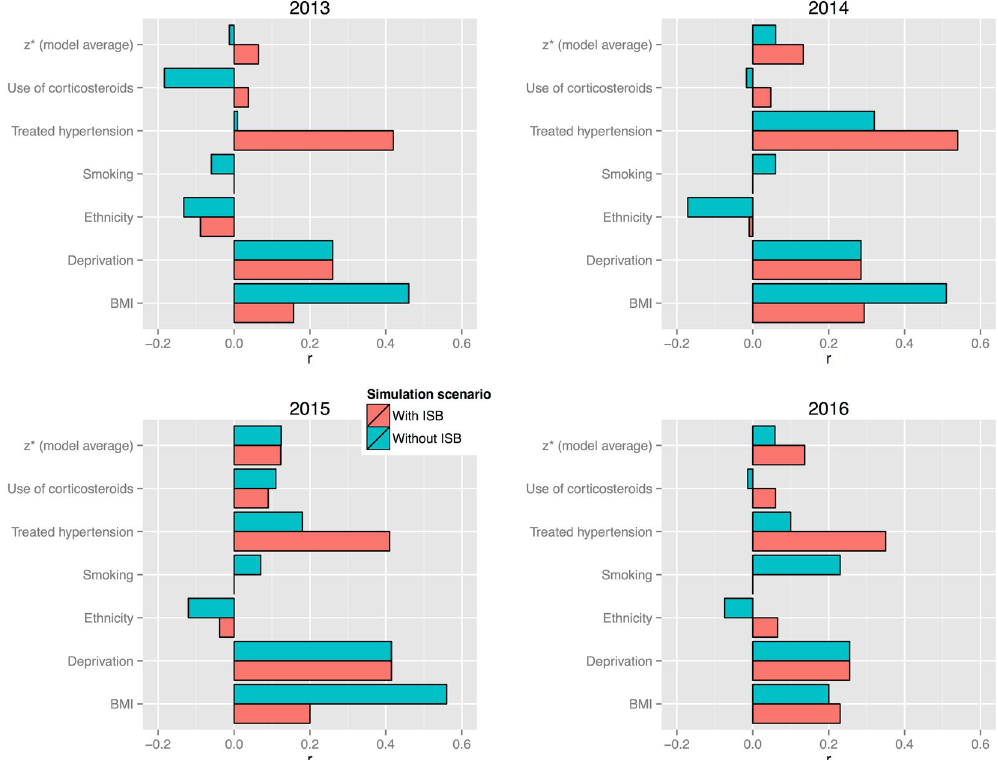
Figure 5. Correlation propensity between keywords, associated with the risk factors, contributing to model scenarios without and with self-diagnosis variable (ISB), and generic search term ‘diabetes’. Fisher-transformed r s indicate stronger correlation trends for the case of the modeling scenario, comprising self-diagnosis variable (‘With ISB’), leading to the conclusion that self-diagnosis can be seen as a mediator for highlighting more dynamic behavioural and lifestyle risk factors. Data source: Google